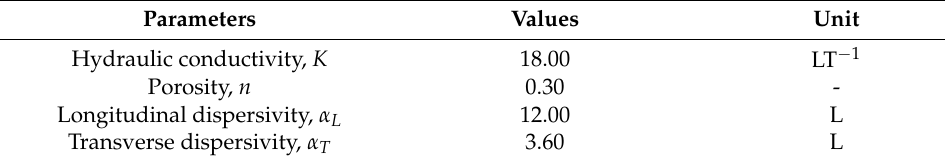
Table 1. Parameters values of simulation model for Case 1.